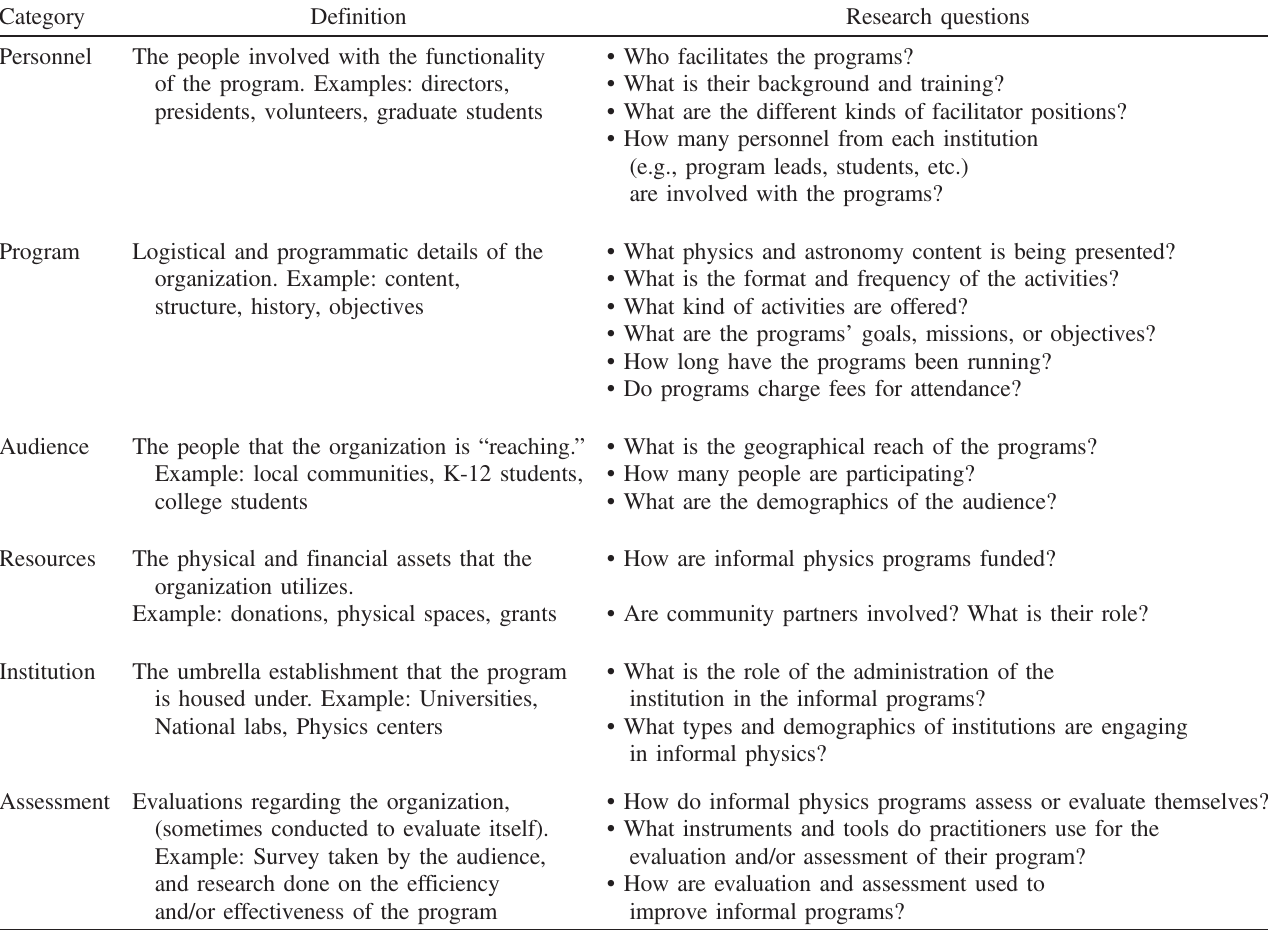
TABLE I. The six main adapted categories, their definitions, and associated research questions for the context of informal physics